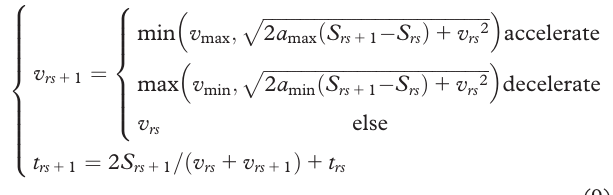
Figure 5 indicates the search fl ow chart of our improved A-star algorithm. Holding the evaluation function [equations (4) – (9)], in